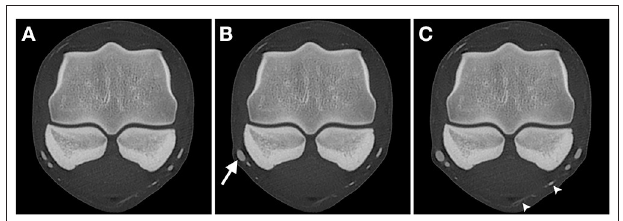
FIGURE 3 | Transverse CT images of limb 3 in a bone algorithm (WW/WL: 800/2,000), showing the comparison of vessel-visualization in the (A) arterial, (B) venous, and (C) arterial-venous combined (AVC) dynamic phase scans obtained at the level of the middle aspect of the proximal sesamoid bones (level A). The digital arteries and veins are markedly flattened in the arterial (A) and venous (B) phase, with only the lateral palmar digital vein being more filled on the venous phase (arrow). In the AVC dynamic phase (C) all vessels appear larger and the medial venous branch of the ergot (arrowheads) is more easily identified. Top of the image is dorsal, left is